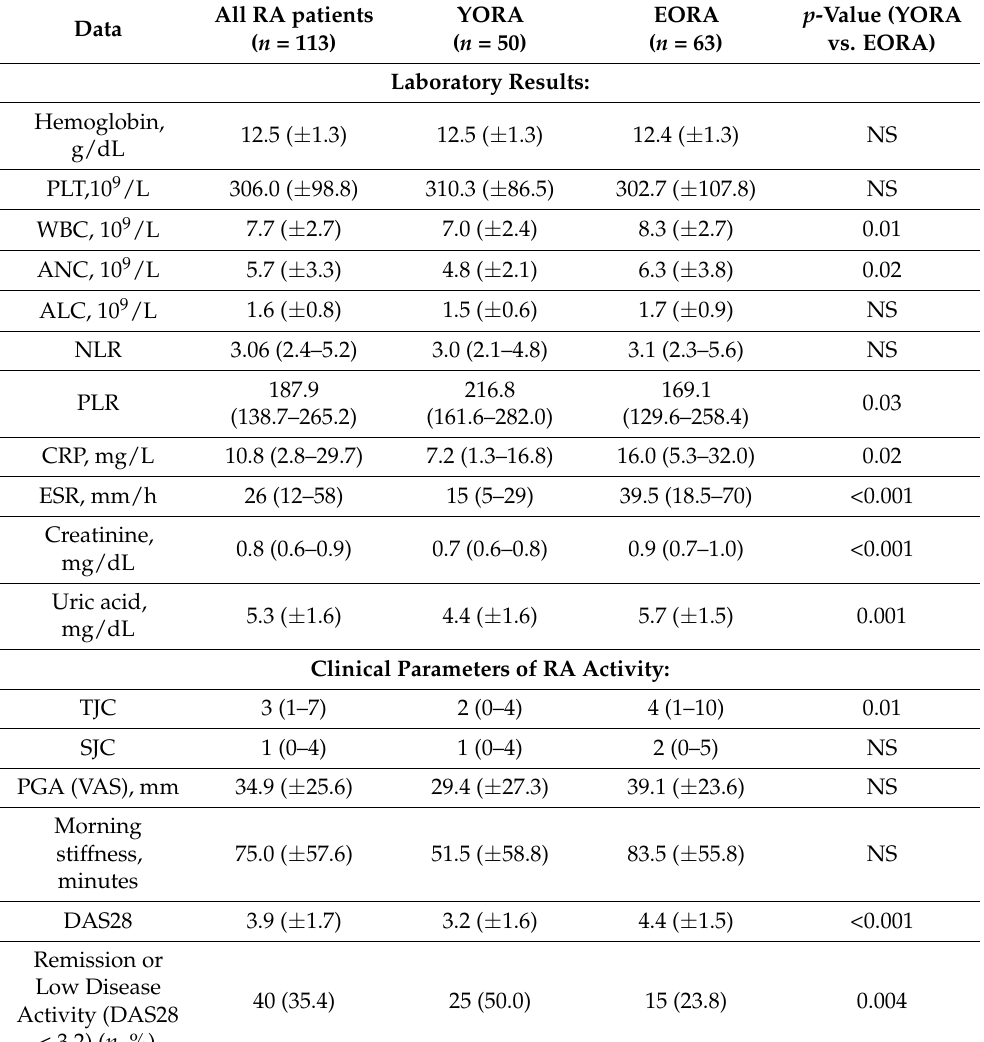
Table 2. Laboratory and clinical parameters in RA